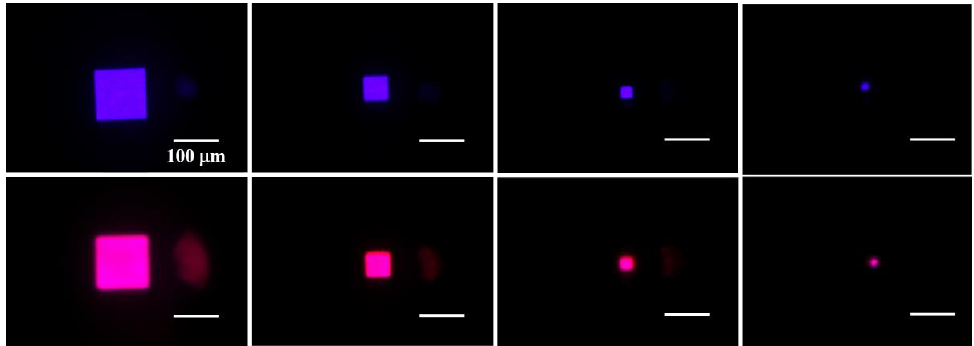
Figure 7. EL optical image of blue and red QD micro-LEDs with size of 100 × 100, 50 × 50, 25 × 25, and 10 × 10 μm 2 .